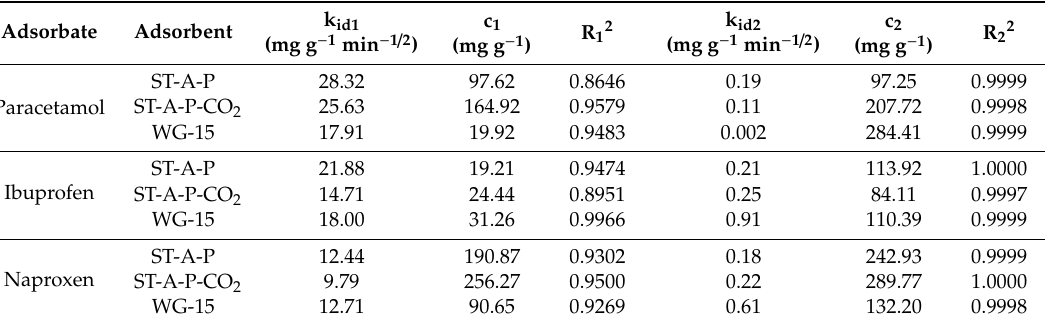
Table 7. Intra-particle di ff usion model